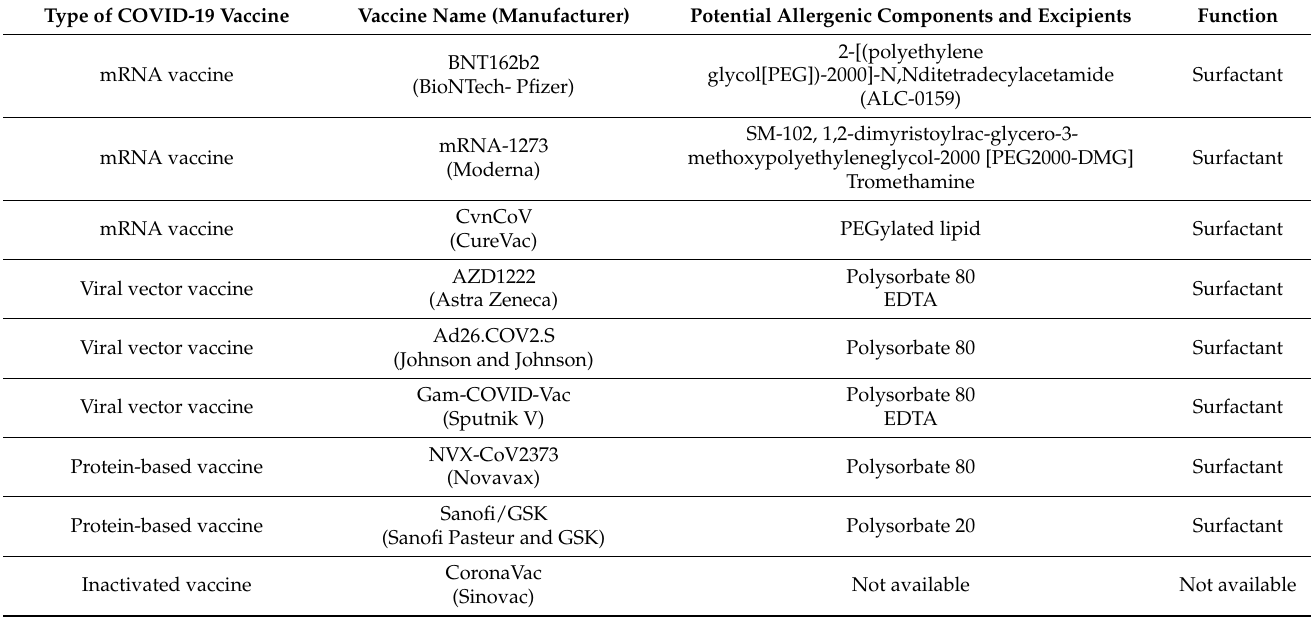
Table 2. The potential allergenic components and excipients of COVID-19